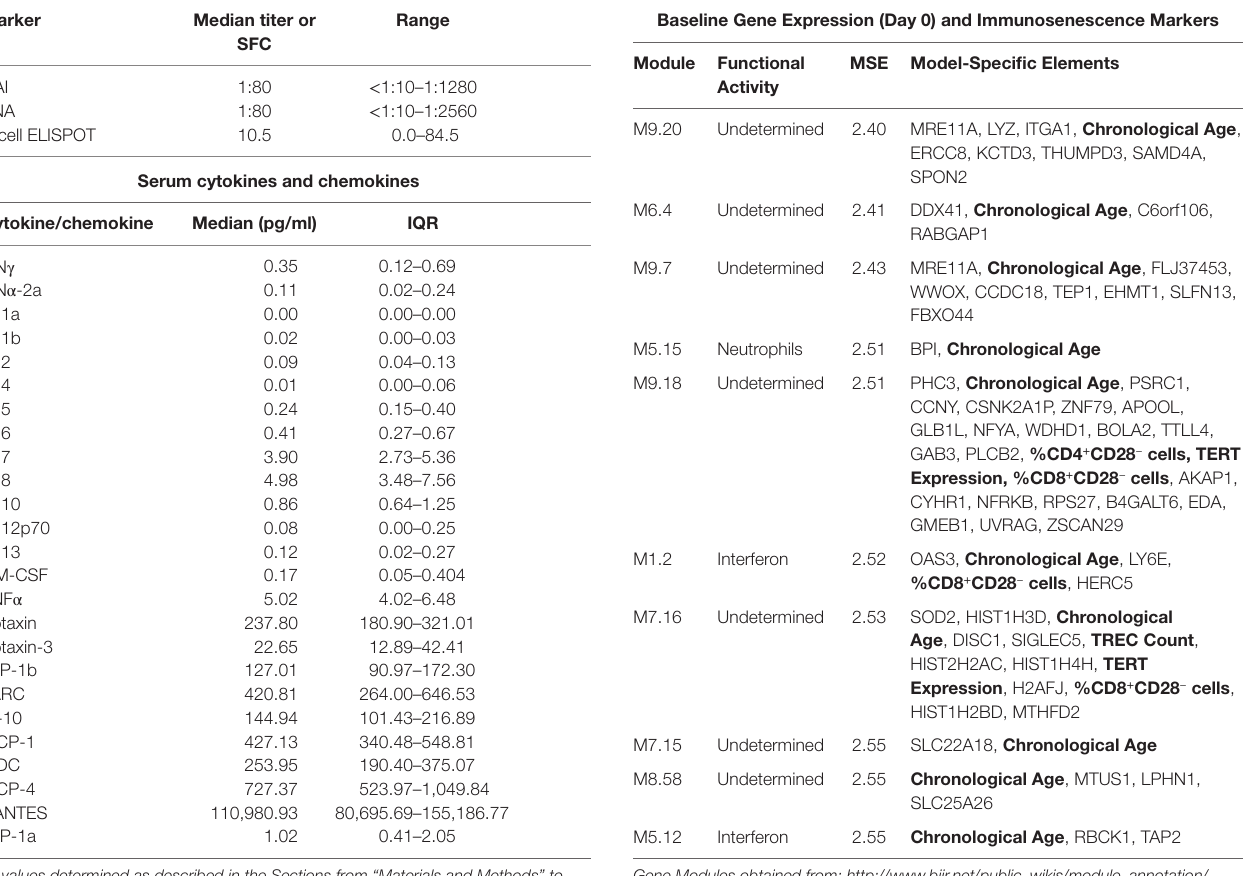
low (%CD4 + CD28 − and %CD8 + CD28 − ), and the CD4 + /CD8 +